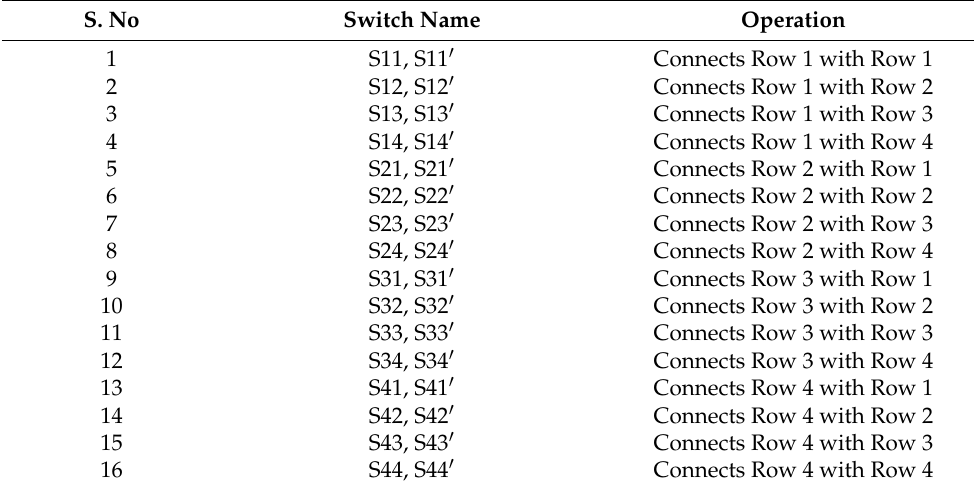
Table 2. Details of switching circuit.